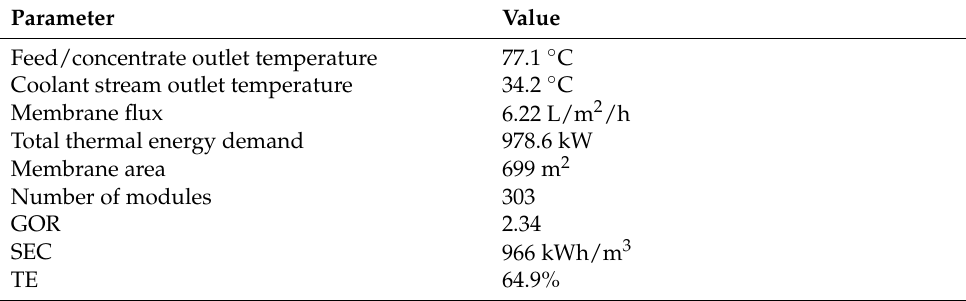
Table 4. Simulation results from the MD